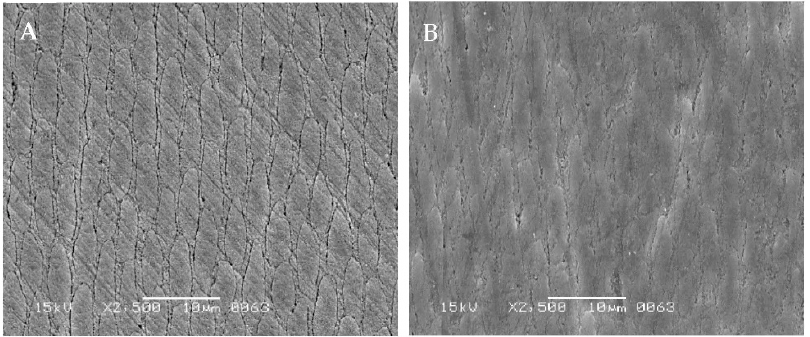
Figure 1. Scanning electron microscopy images of enamel surface. ( A ) C-gel-treated enamel surface; ( B ) Tooth surface after CAP system treatment. (Gold deposition sample, Scale bar, 10 μ m).